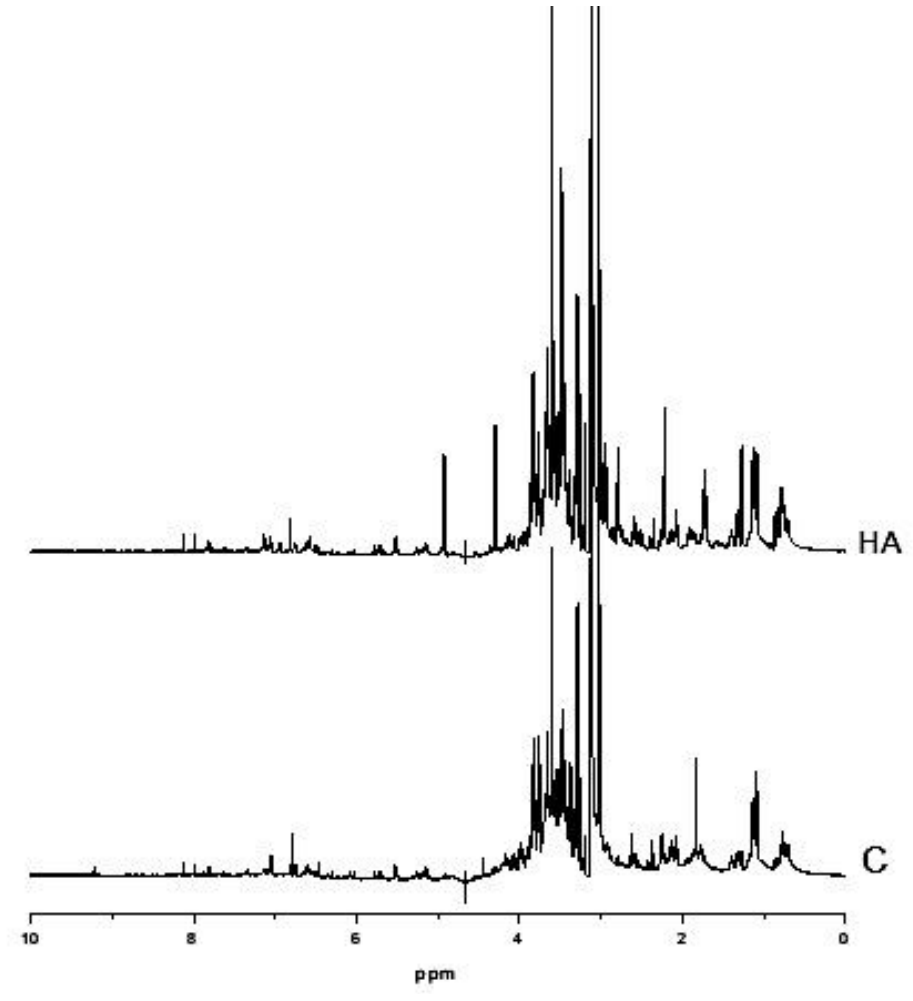
Figure 2. 1 H NMR spectra of rice leaf extracts from seedlings treated with humic acids (HA) or not (C).